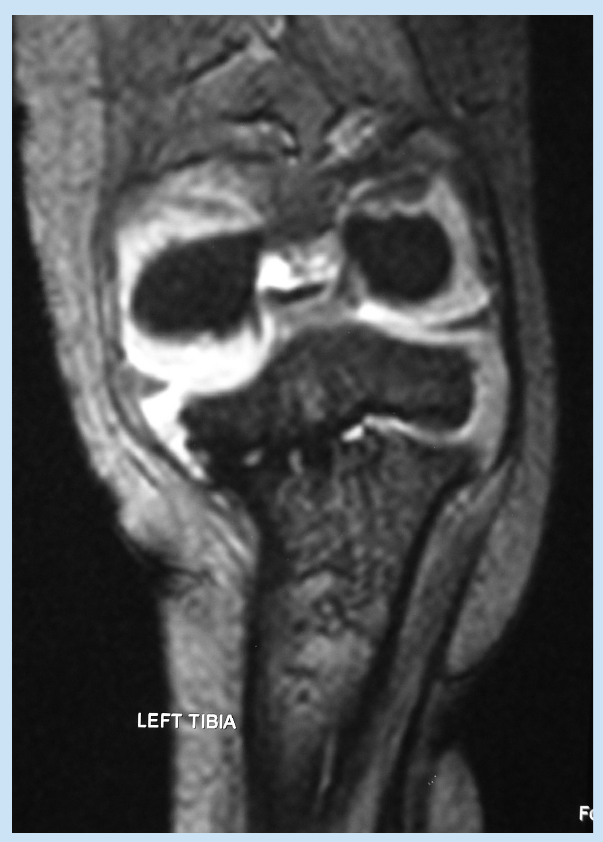
Fig. 3. Postmeningococcal physeal bar – a coronal gradient echo image demonstrates that the irregularity of the medial aspect of the proximal tibial physis is a result of multiple small bars.